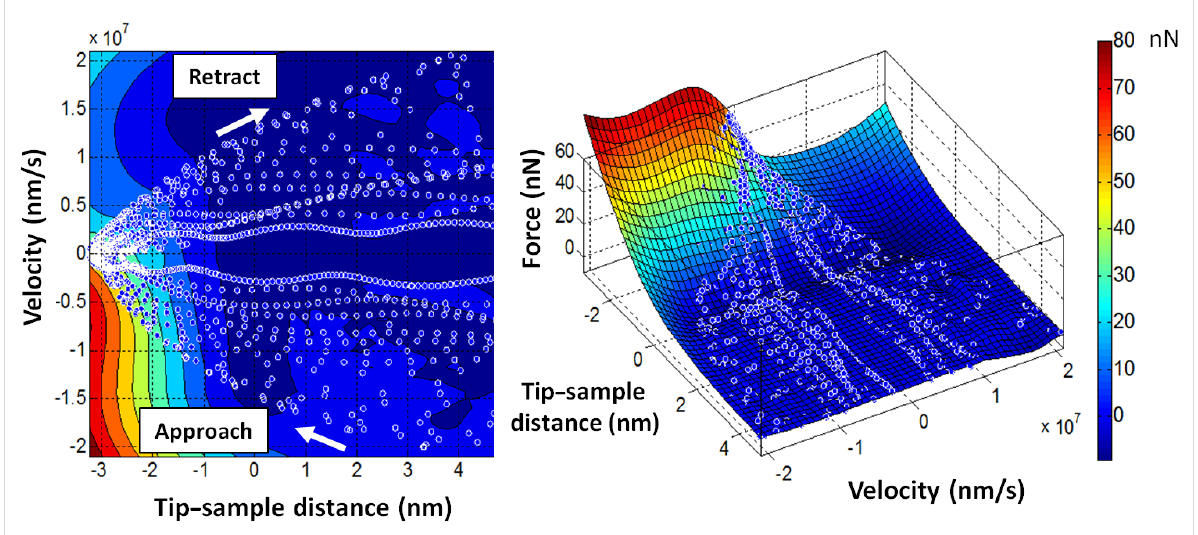
Figure 2: Collection of reconstructed tip–sample interaction force curves for a fixed ( x , y ) point on the surface, each similar to that shown in Figure 1 (expanded representation), plotted together as a plane. In this simulation, different force curves were acquired for different rest positions of the cantilever above the surface and were all plotted together. The plots show two different views of the same data. The white open circles represent points and each force curve is a succession of such points that follows the direction indicated by the white arrows. That is, during the ap- proach, the tip travels towards and into the surface (with negative velocity) down to the turning point, and then travels upward (with positive velocity) away from the sample. Different force curves have different incoming and outgoing velocity.